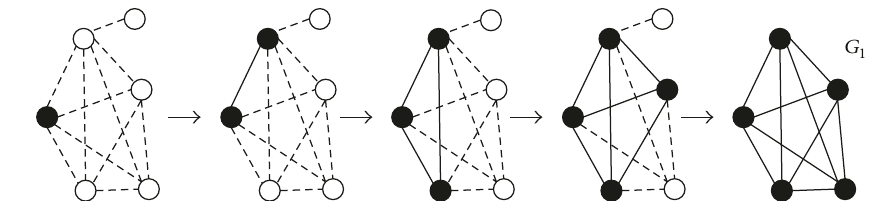
Figure 6: Search process of complete subgraph.